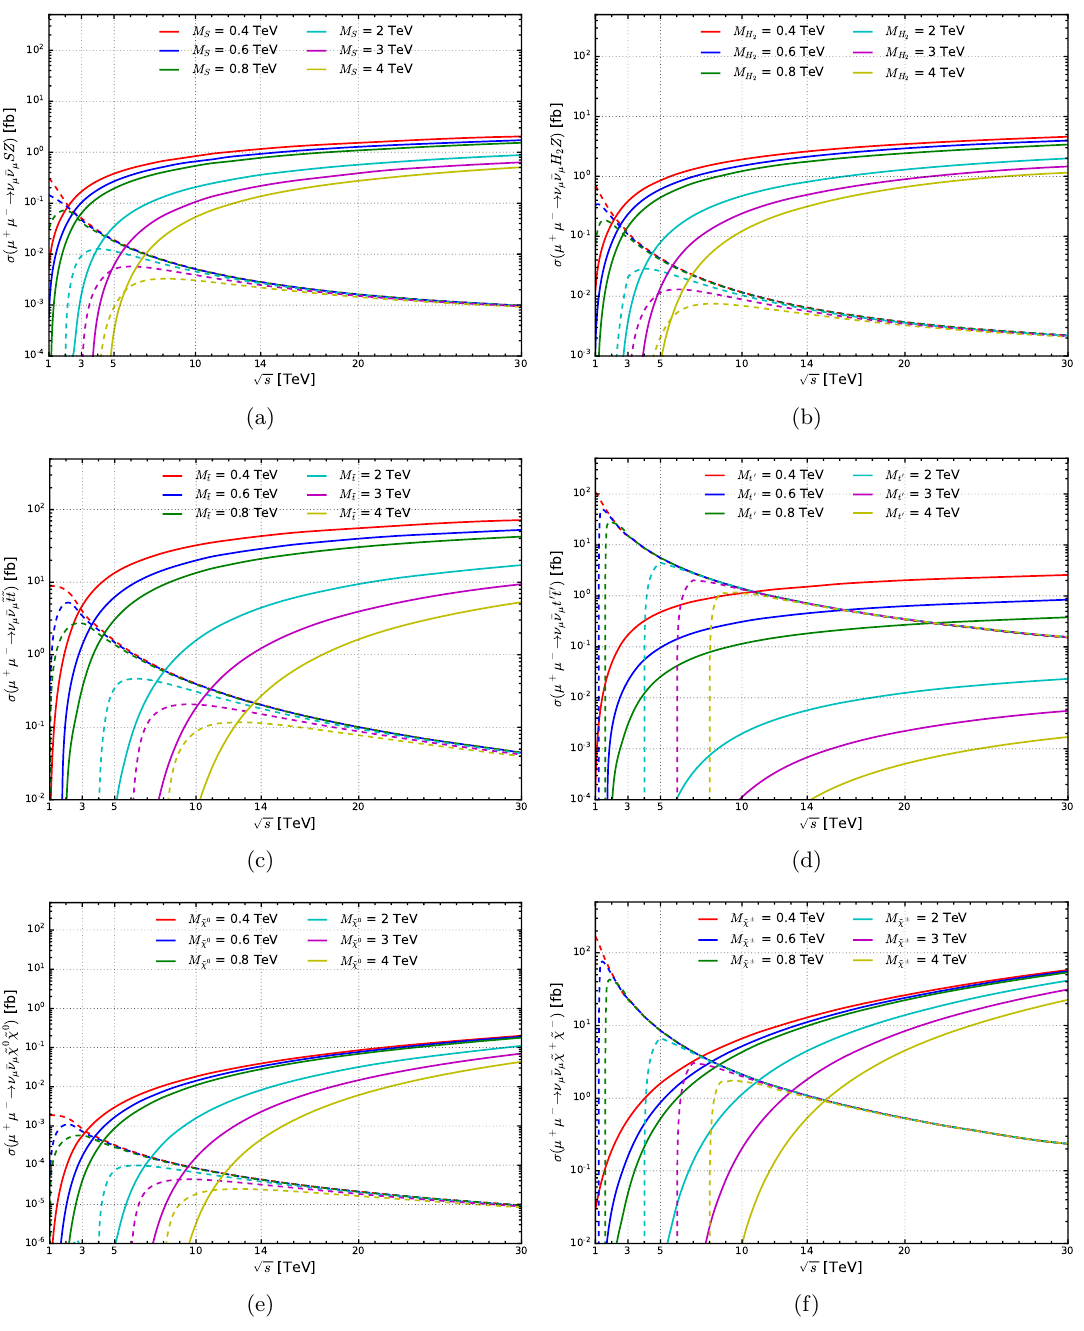
Figure 17 . For representative input parameters and as a function of muon collider energy [TeV], the cross section [fb] via VBF (solid lines) and s -channel annihilation (dashed lines) for: (a) SZ associated production in a singlet-scalar extension of the SM (section 6.1); (b) H 2 Z associated production in the 2HDM (section 6.2); (c) ~ t ~ t pair production in the MSSM (section 6.4); (d) t 0 t 0 pair production in a vector-like quark scenario (section 6.7); (e) ~ (cid:31) 0 ~ (cid:31) 0 pair production in the MSSM; and (f) ~ (cid:31) + ~ (cid:31) (cid:0) pair production in the MSSM.